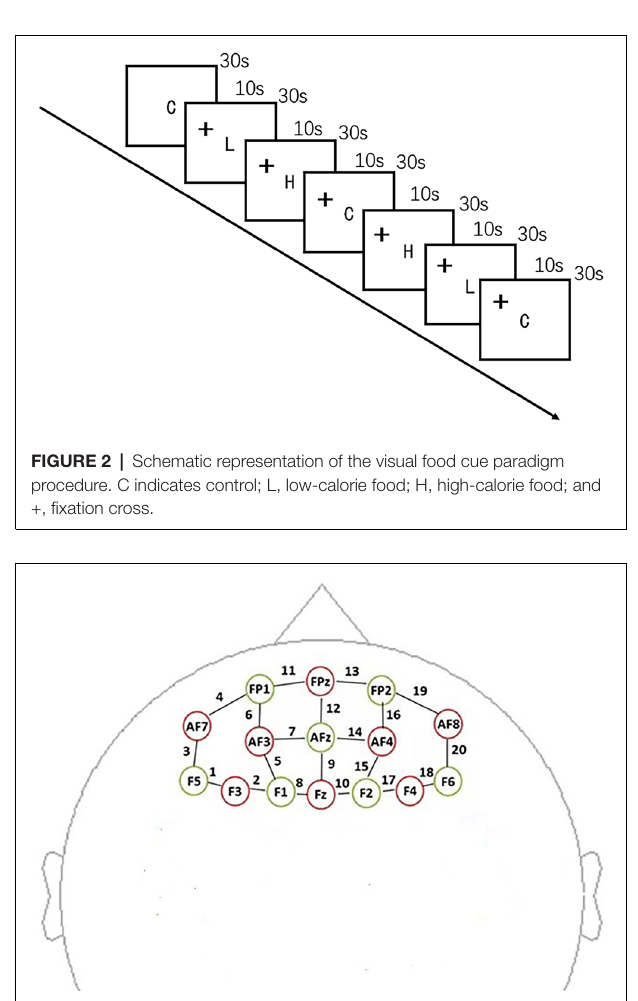
FIGURE 3 | Schematic showing the near-infrared spectroscopy (NIRS) probe array arrangement (front view). The NIRS probe comprises eight sources (red) and seven detectors (yellow). We defined the channel location as the midpoint of the source-detector distances, labeled 1–20. appetite self-rating system (Gibbons et al., 2011).